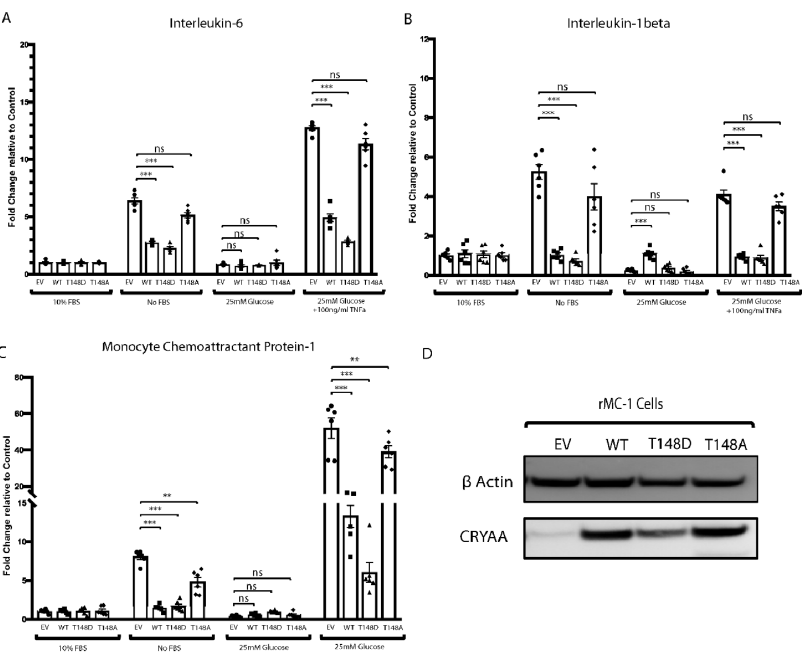
Figure 1. Metabolic-stress-induced expression of pro-inflammatory mediator is regulated by HspB4/ α A-crystallin expression. rMC-1 cells were transfected with either empty vector (EV), wild-type HspB4/ α A-crystallin (WT), phosphomimetic form of HspB4/ α A-crystallin (T148D), or non-phosphorylatable form of HspB4/ α A-crystallin (T148A). Then, 24 h post transfection, cells were either exposed to normal media (10% FBS), serum starvation (no FBS), high glucose (25 mM glucose), or to diabetic like stress (25 mM glucose + 100 ng/mL TNF α ) for 4 h. The mRNA levels of ( A ) interleukin-1 beta (IL-1 β ), ( B ) interleukin-6 (IL-6), and ( C ) monocyte chemoattractant protein-1 (MCP-1) were normalized to the actin-encoding gene Actb . ( D ) Representative immunoblot depict- ing the expression of HspB4/ α A-crystallin in transfected rMC-1 cells. ** p ≤ 0.01, *** p ≤ 0.001, significantly different from the respective EV-transfected cells. Each endpoint was measured on a minimum of six technical replicates. Statistical analysis was performed by one-way ANOVA followed by Student–Newman–Keuls